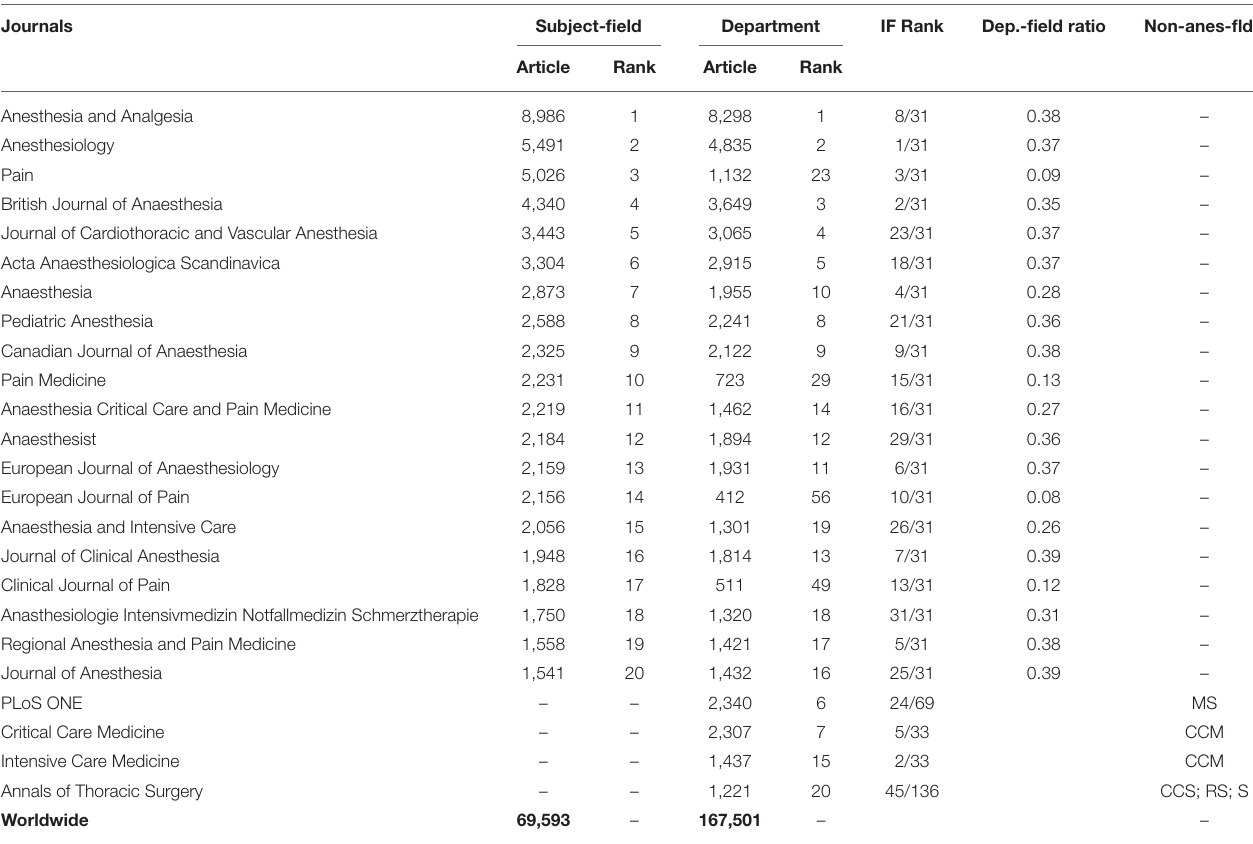
TABLE 1 | The top 20 journals by number of articles from the subject-field dataset and department dataset in 1999–2018.